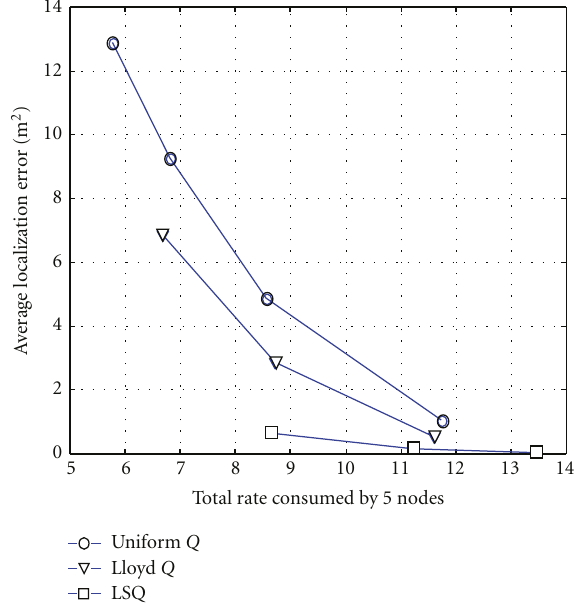
Figure 5: Average localization error versus total rate R M for three di ff erent quantization schemes with distributed encoding algorithm. Average rate savings is achieved by the distributed encoding algorithm (global merging